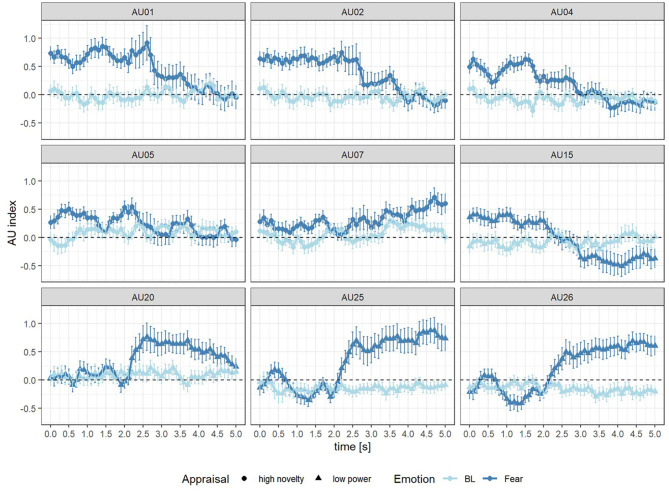
AU index of Fear (dark blue) and Baseline (BL, light blue) in 0–5 s after the onset of event for AU 1, 2, 4, 5, and 7 (high novelty) as well as AU 15, 20, 25, and 26 (low power).